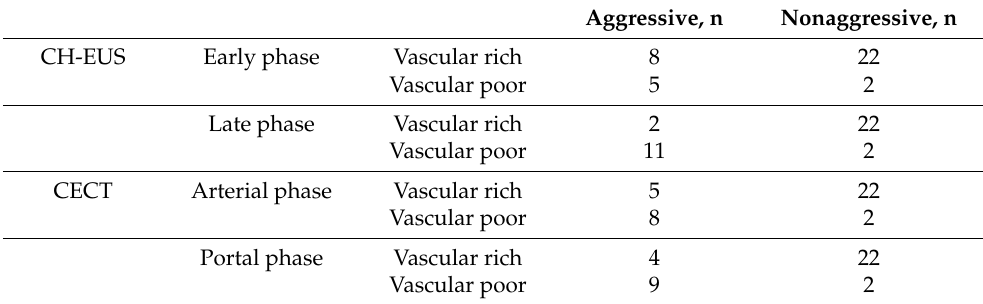
Table 3. Enhancement patterns of PanNENs on CH-EUS and CECT.